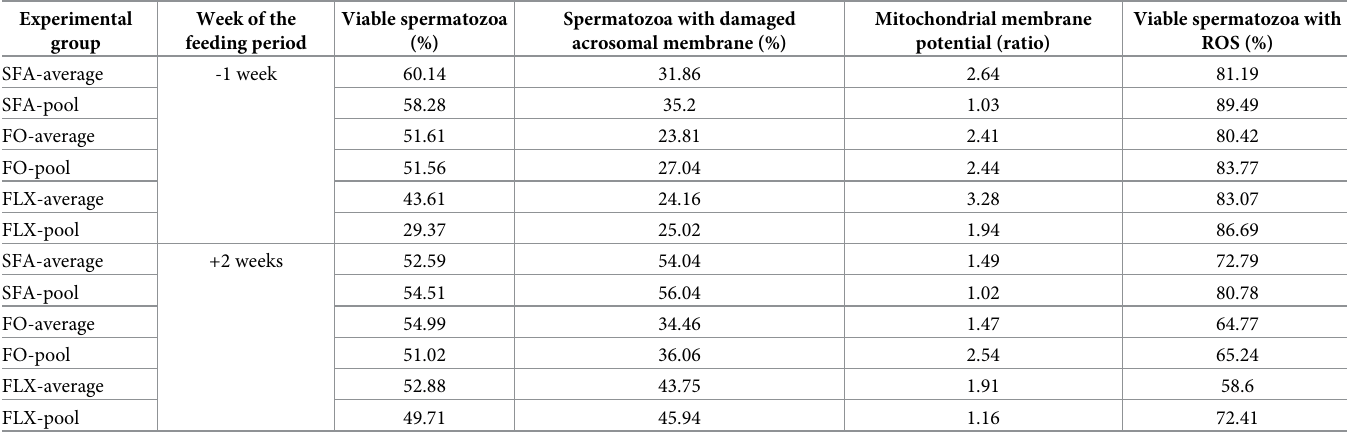
Table 2. Comparison of the quality parameters from 5 bulls (i.e., the average data) with data of the pooled samples at -1 week and +2 weeks of the feeding period. Experimental